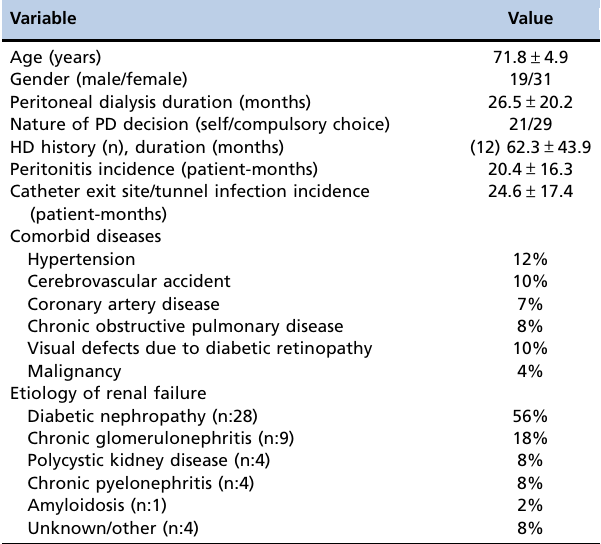
Table 1 - Demographic data of